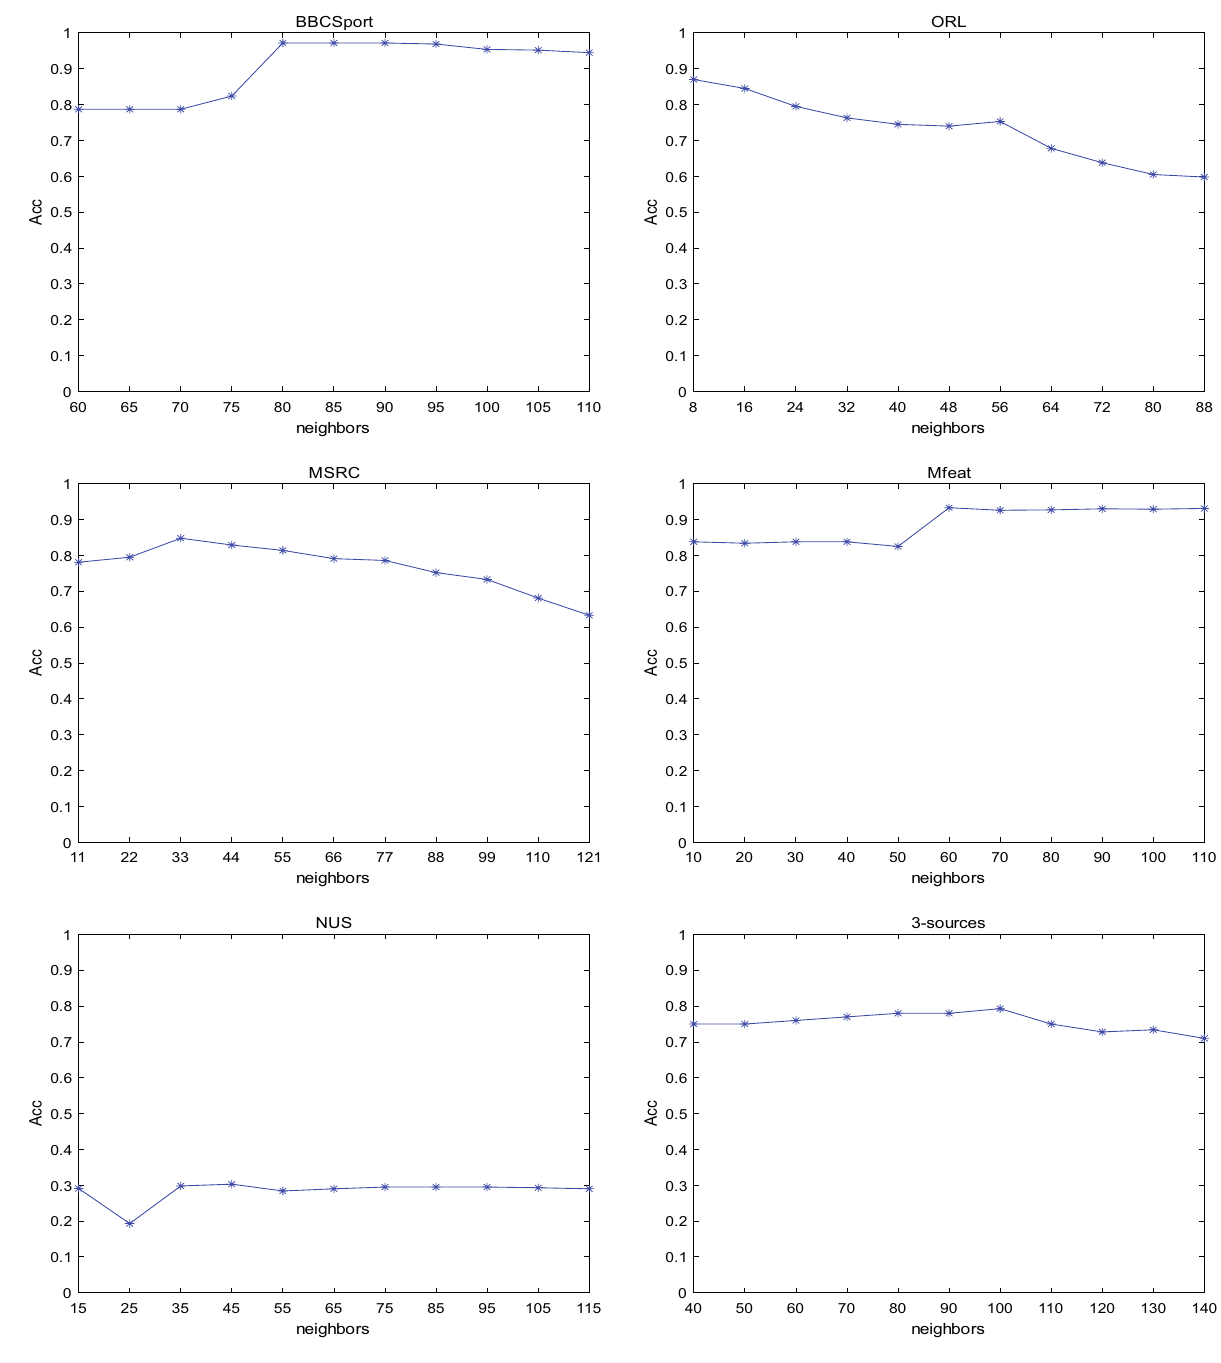
Figure 7. Impact of the change in the number of neighbors on